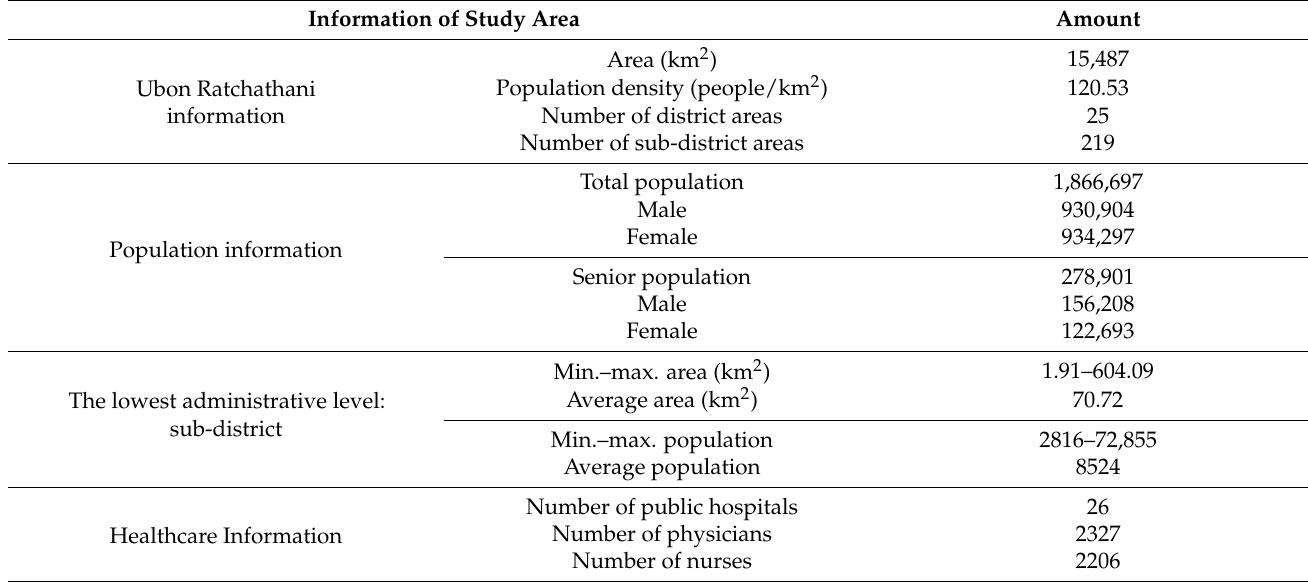
Table 2. Summary of statistics data of study